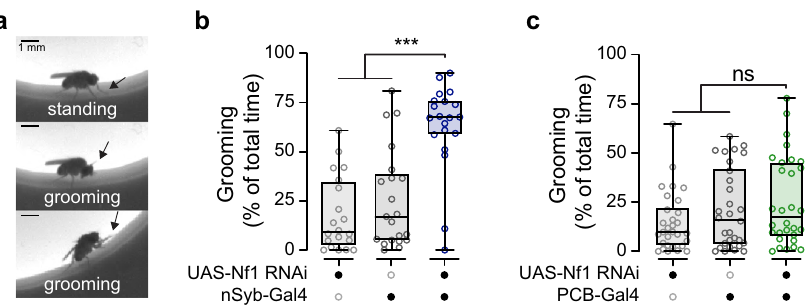
Fig. 4 Knockdown of Nf1 in PCB-Gal4 + neurons does not affect spontaneous grooming. a Representative images of fl y grooming in an open fi eld. Top panel: a fl y standing in place (not grooming). Middle panel: a fl y grooming its head. Bottom panel: a fl y grooming its prothoracic (front) legs. In all panels, an arrow points to the prothoracic leg location. Scale bars = 1 mm. b Quanti fi cation of grooming in fl ies in which Nf1 has been knocked down pan- neuronally with the nSyb-Gal4 driver. *** p < 0.001 (Kruskal – Wallis, two-sided; n = 20 UAS-Nf1 RNAi/ + , n = 21 nSyb-Gal4/ + , n = 21 experimental group). c Quanti fi cation of grooming in fl ies in which Nf1 has been knocked down with the PCB-Gal4 driver. ns: not signi fi cant. p = 0.209 (Kruskal – Wallis, two- sided; n = 30). Each “ n ” = single fl y. Box plots — box: 1st to 3rd quartiles, median: line, whiskers: min – max, individual data points: circles. ns: not signi